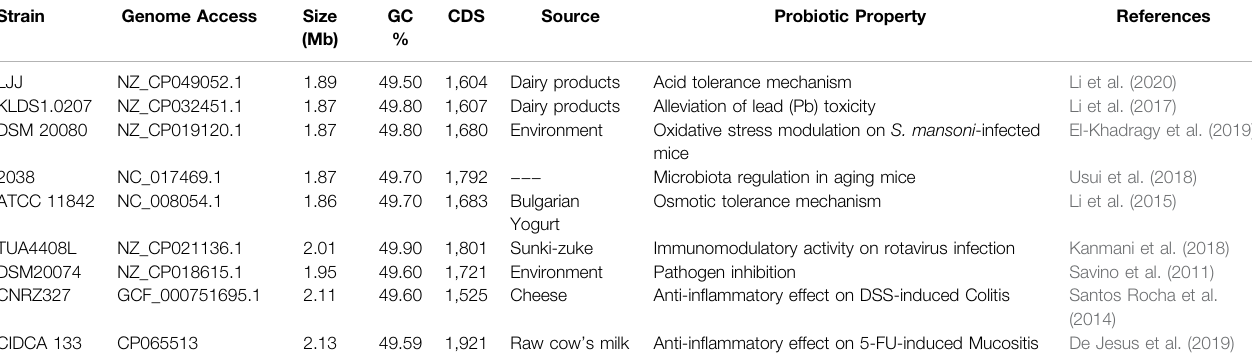
TABLE 1 | Genome features of Lactobacillus delbrueckii strains used in this study. Strain Genome